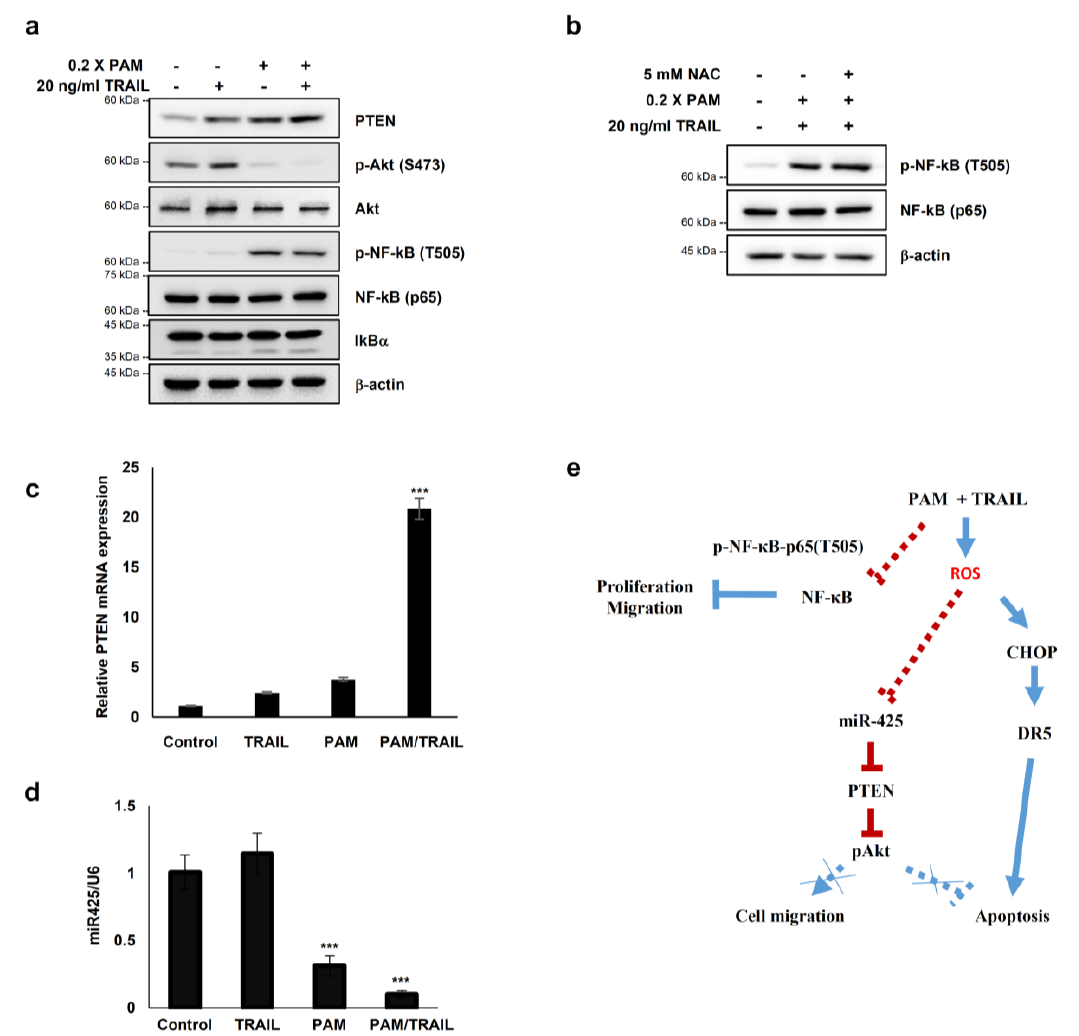
Figure 6. PAM sensitizes cancer cells to TRAIL-induced apoptosis via modulation of the miR-425-PTEN-Akt axis. ( a – d ) HeLa cells were treated with TRAIL with or without PAM for 24 h. ( a ) PTEN, phospho-Akt1 (S473), Akt1, NF- κ B, phospho-NF- κ B (T505) and I κ B α protein levels were determined by immunoblotting. β -actin was used as a loading control. ( b ) HeLa cells were pretreated with 5 mM NAC for 1 h before TRAIL treatment in the presence of PAM. After 24 h, phosphor-NF- κ B (T505) and NF- κ B protein levels were observed by immunoblot analysis. ( c ) PTEN mRNA levels were determined by qRT-PCR. *** p < 0.001. ( d ) miR-425 levels were determined via qRT-PCR. *** p < 0.001. ( e ) Proposed model for PAM-mediated TRAIL sensitization. Our work has revealed that combinational treatment with PAM and TRAIL stimulates ROS-dependent apoptosis by two attributes; (1) via CHOP-mediated upregulation of DR5 transcription (solid blue line), and (2) via miR-425 suppression-mediated PTEN upregulation, resulting in Akt inactivation (solid red line). In this study, PAM and TRAIL cotreatment induces inhibitory phosphorylation of NF- κ B (solid red line). Previous studies have provided evidences that active NF- κ B and phospho-Akt promote proliferation and migration (dotted blue lines).